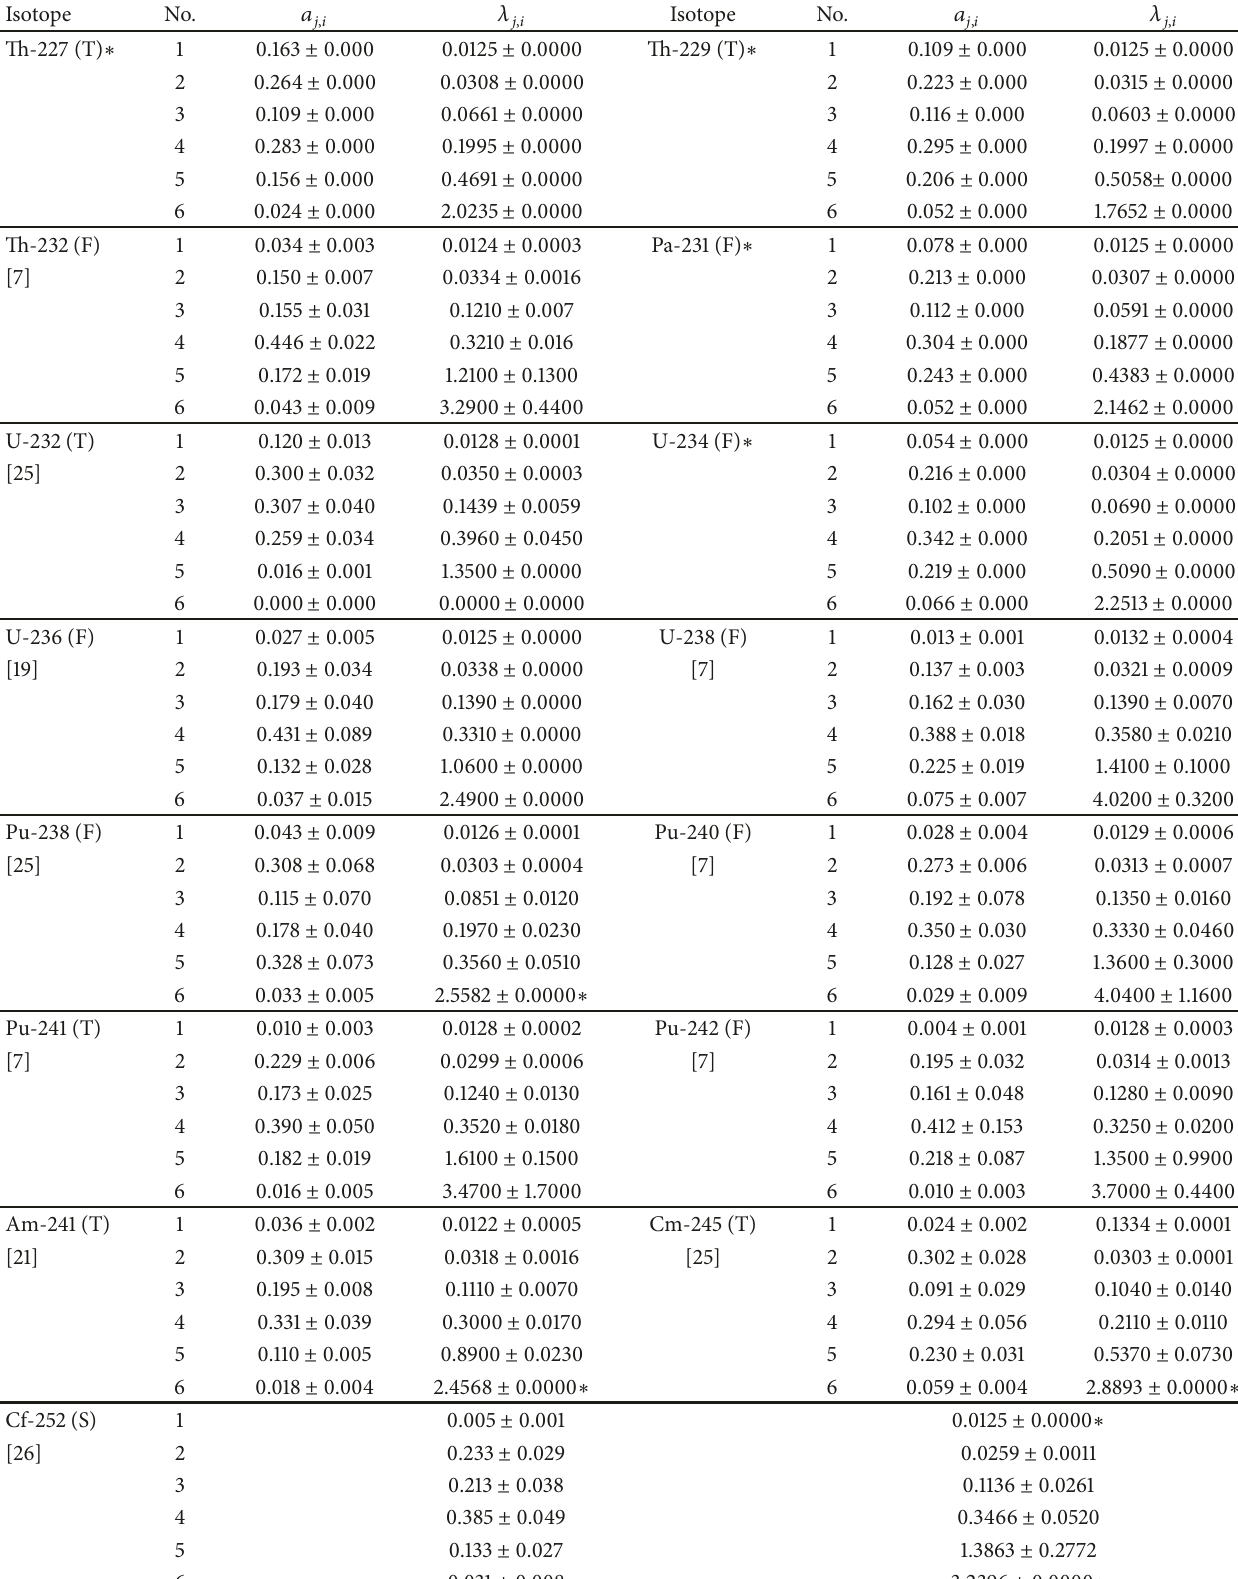
Table 2: Delayed neutron group data for isotopes delayed neutrons are assigned to either thermal or fast fission